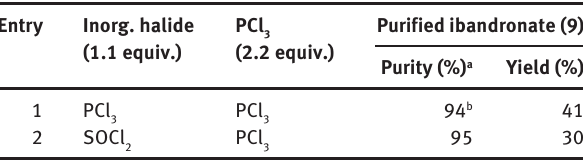
Table 4 Synthesis of ibandronate in two steps (1., 26 ° C/6 h,